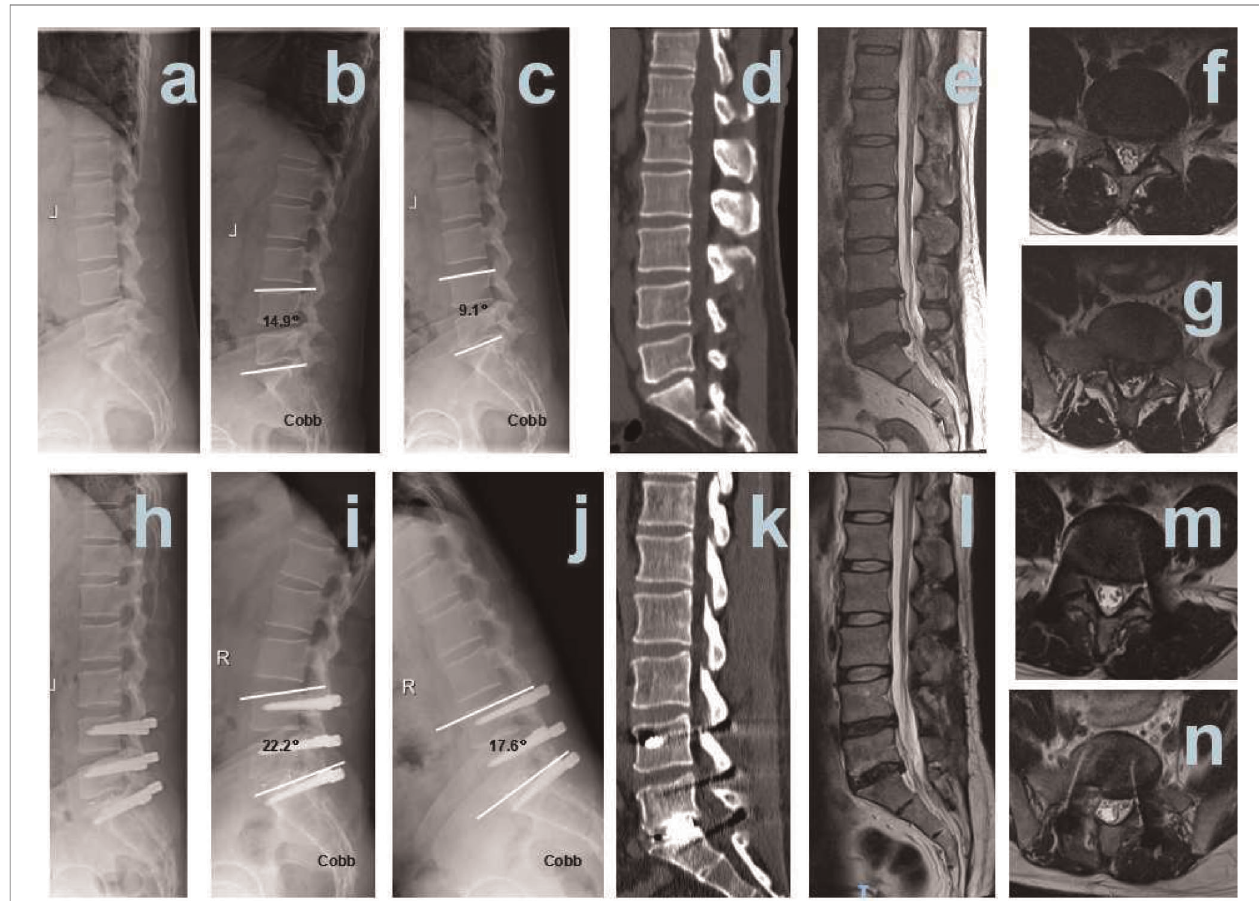
FIGURE 4 | Hybrid patient 2. ( A ) Pre-surgical lateral X-ray; ( B ) pre-surgical hyper-extension X-ray; ( C ) pre-surgical hyper- fl exion X-ray; ( D ) pre-surgical CT showed L5 I° spondylolisthesis; ( E ) pre-surgical T2 weighted MRI sagittal plane showed L4/5, L5/S1 disc herniation; ( F ) pre-surgical MRI showed L4/5 disc herniation and spinal stenosis; ( G ) pre-surgical MRI showed L5/S1 disc herniation and spinal stenosis; ( H ) 12 months after surgery, Post-surgical lateral X-ray; ( I ) 12 months after surgery, post-surgical hyper-extension X-ray; ( J ) 12 months after surgery, post-surgical hyper- fl exion X-ray; ( K ) 12 months after surgery, post-surgical CT showed interbody fusion; ( L ) 12 months after surgery, post-surgical T2 weighted MRI sagittal plane; ( M ) 12 months after surgery, post-surgical MRI sagittal plane showed that L4/5 spinal stenosis was improved signi fi cantly; and ( N ) 12 months after surgery, post-surgical MRI sagittal plane showed that L5/S1 spinal stenosis was improved signi fi